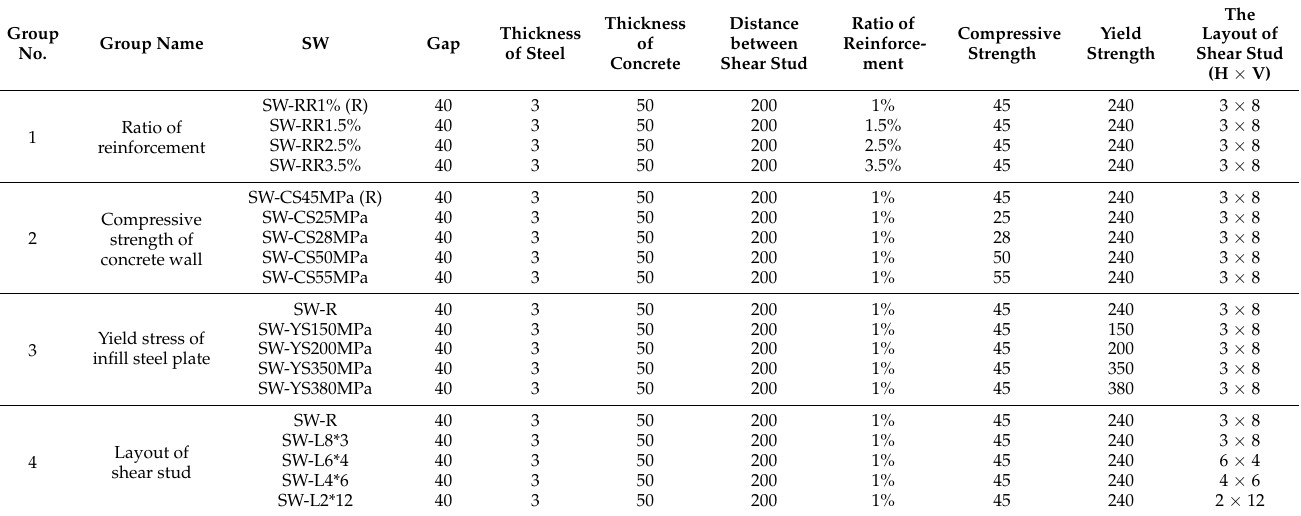
Table 1. Details of the experimental specimens and mechanical properties.